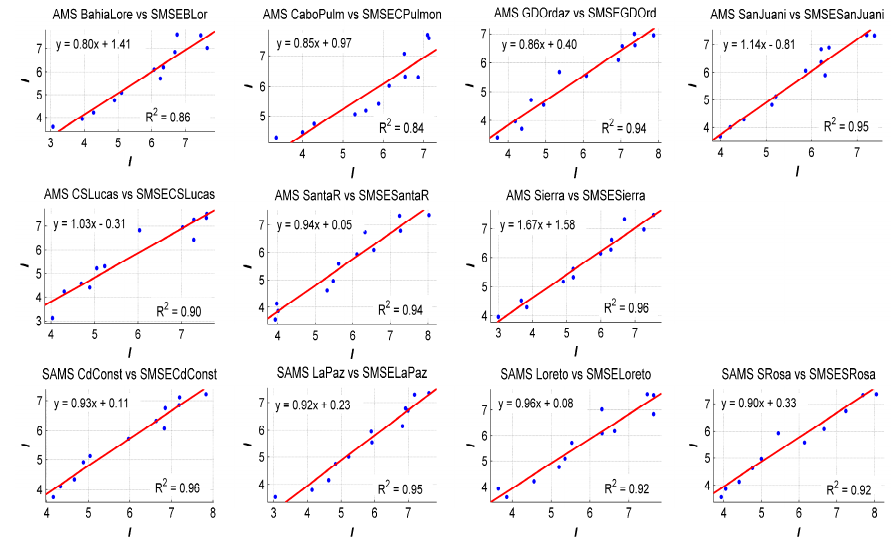
Figure 5. Monthly satellite versus measured data for each meteorological station in Baja California.